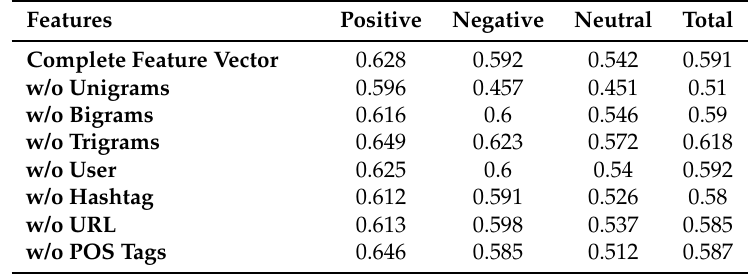
Table 12. F-Measure for Ternary Classification for Logistic Regression for 12,500 tweets.